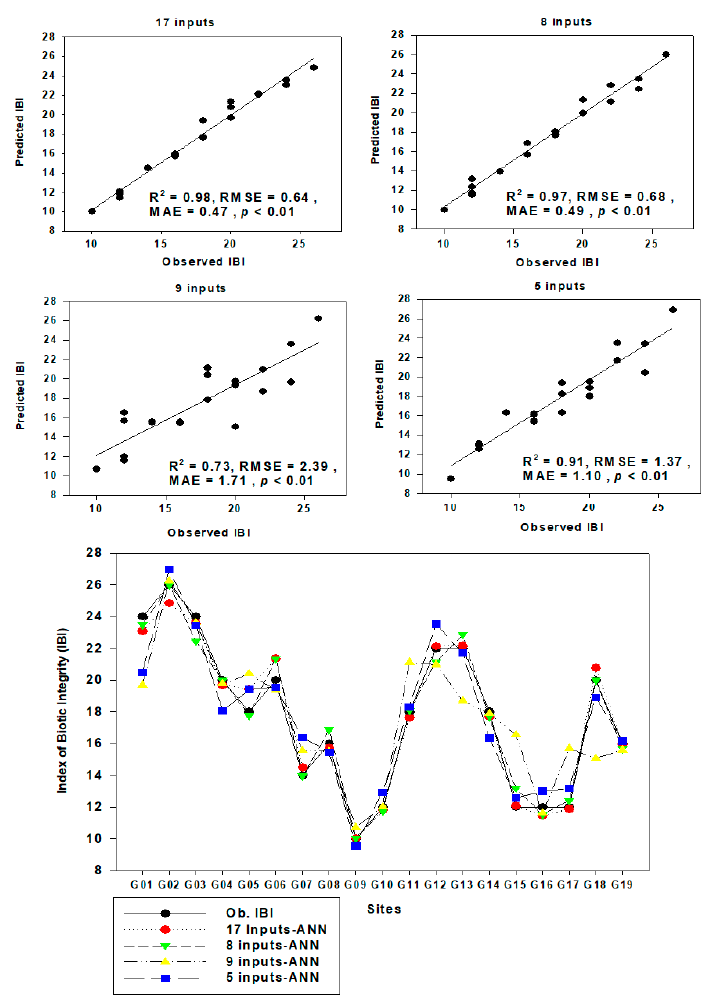
Figure 10. Prediction of IBI using artificial neural network tool in the Geum River watershed.